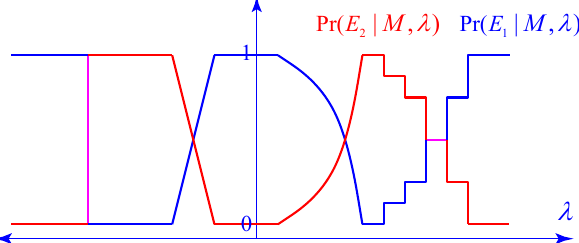
Figure 6: A possible conditional probability distribution Pr ( E j | M , λ ) for a two outcome measurement M = { E 1 , E 2 } in an ontological